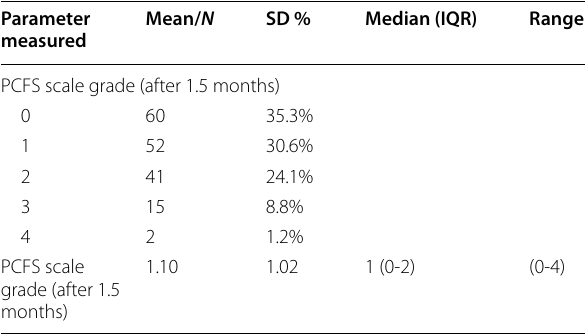
Table 4 Descriptive of post COVID-19 functional status scale in our patients after one and half months